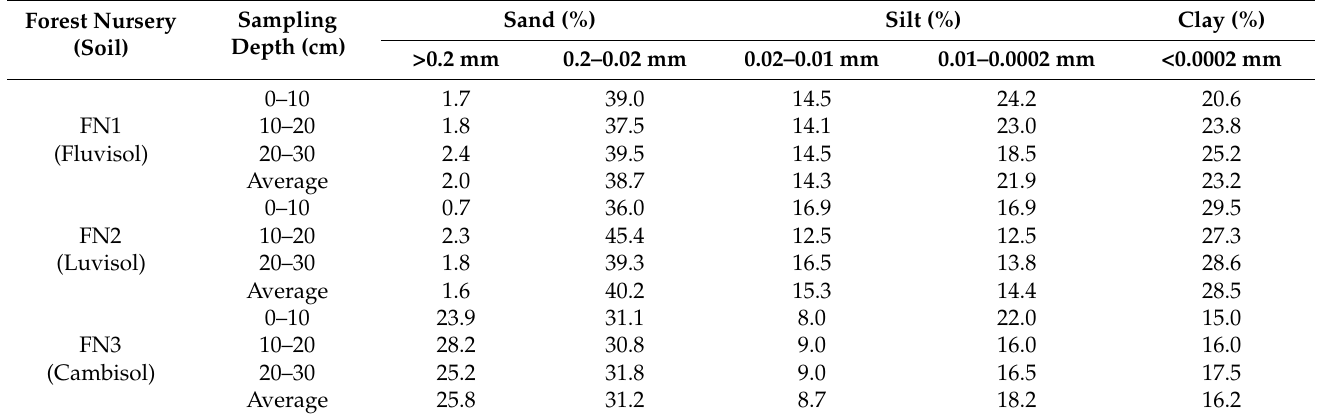
Table A1. Results of the analysis on soil particle size.